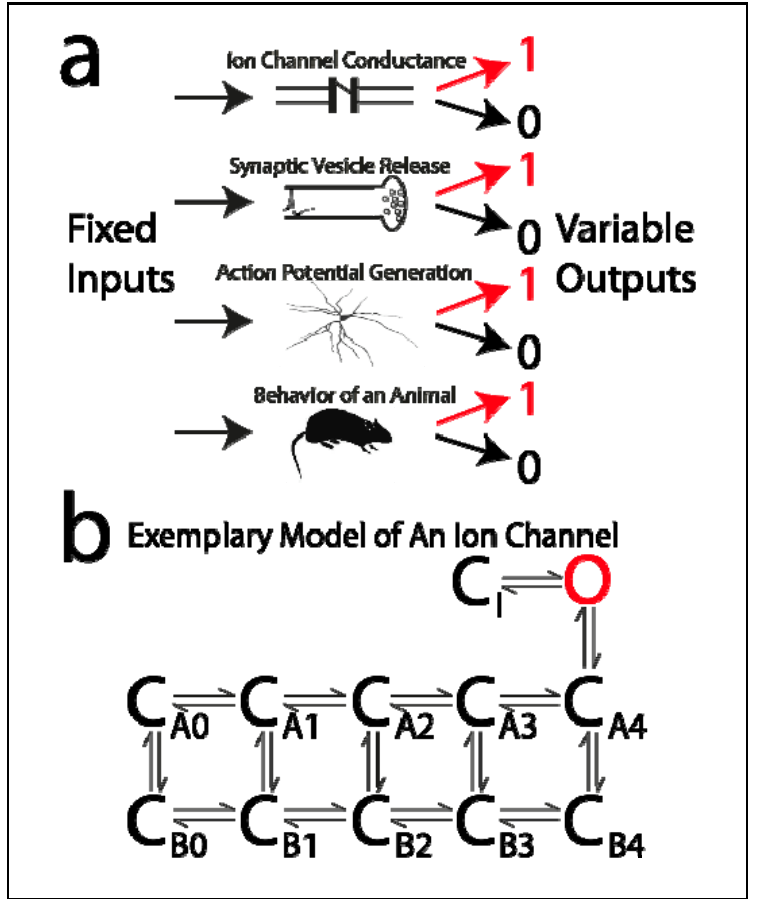
Figure 3. Illustration of neural systems that are sometimes said to be “random, stochastic, noisy, or probabilistic.” ( a ) Fixed and known inputs to these systems result in variable outputs. From top to bottom: In response to a certain concentration of neurotransmitter, or a specific membrane voltage, an ion channel can be open or closed; in response to arrival of an action potential, a presynaptic terminal may or may not release a vesicle of neurotransmitter; in response to a given amount of excitatory postsynaptic current, a neuron may or may not generate an action potential; in response to a given temperature, a rat may or may not remove its tail from a hotplate. According to contemporary physics, none of these systems are “random”, “stochastic”, etc . These terms purport to describe a physical system, but they only indicate our ignorance of the system; ( b ) an example of a typical model of an ion channel. The channel can exist in any one of multiple states. With a patch electrode, we can only discriminate open (“O”) from closed (“C”) states. The various closed states are “hidden” from our observation, but we can infer their existence through careful analysis. The other three cases illustrated in “a” are analogous, but because they are less microscopic in scale, their “hidden” states can be more readily